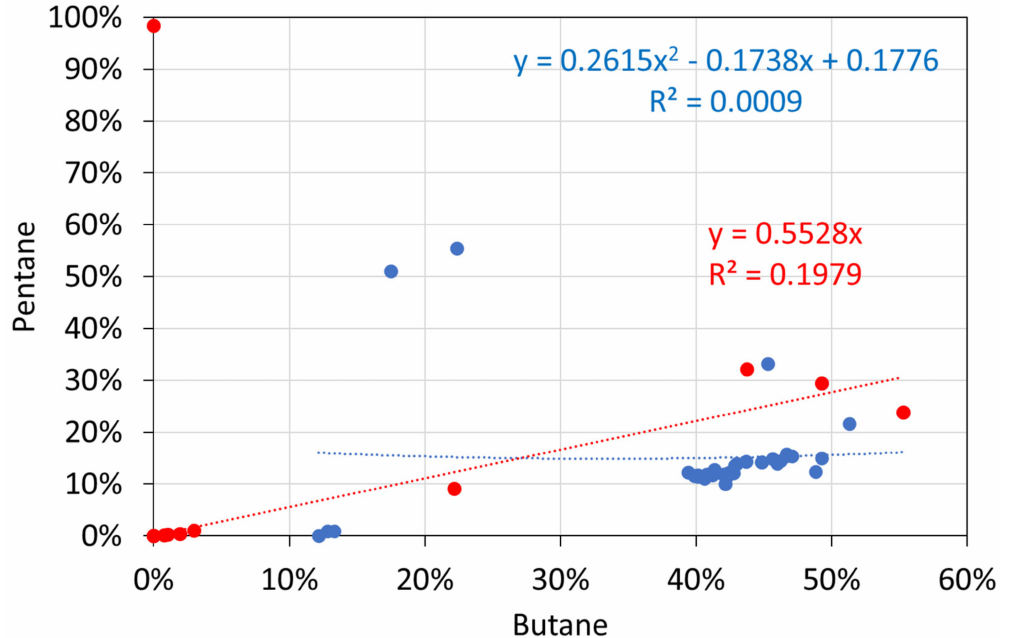
Figure A9. Molar alkane gas analyses: butane vs. pentane. Blue circles: T ≤ 298 K; red circles: T = 348 K.